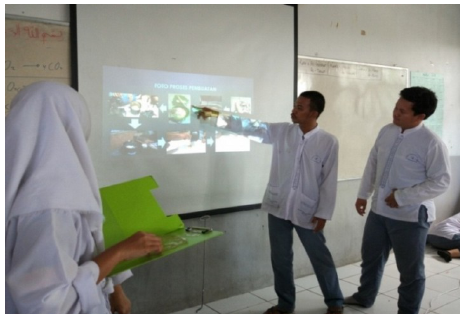
Figure 7. Students presenting their results